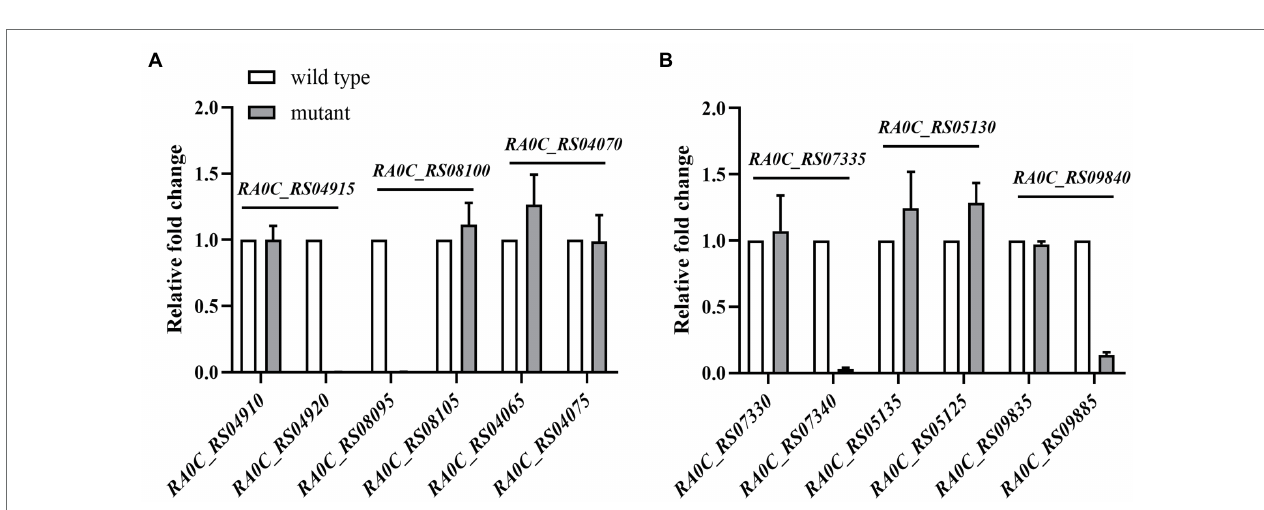
FIGURE 3 | Detection of the polar effect of transposon insertion mutants No. 236, No. 307, No. 719, No. 175, No. 132, and No. 26 by real-time PCR (qRT-PCR). The insertion sites of the transposon in No. 236, No. 307, No. 719, No. 175, No. 132, and No. 26 are RA0C_RS04915 , RA0C_RS08100 , RA0C_RS04070 , RA0C_RS07335 , RA0C_RS05130 , and RA0C_RS09840 , respectively. The transposon-inserted genes are shown above the horizontal line in the figures, The blank bars and grey bars represent the transcription level of upstream and downstream genes of transposon-inserted genes in the wild type RA ATCC11845 and transposon insertion mutants, respectively. The name of upstream and downstream gene of each transposon-inserted gene are shown under X axis. The relative fold change was calculated with the delta-delta Ct method. 16S rRNA was used to normalize the RNA quantity. The error bars represent the standard deviations of three independent